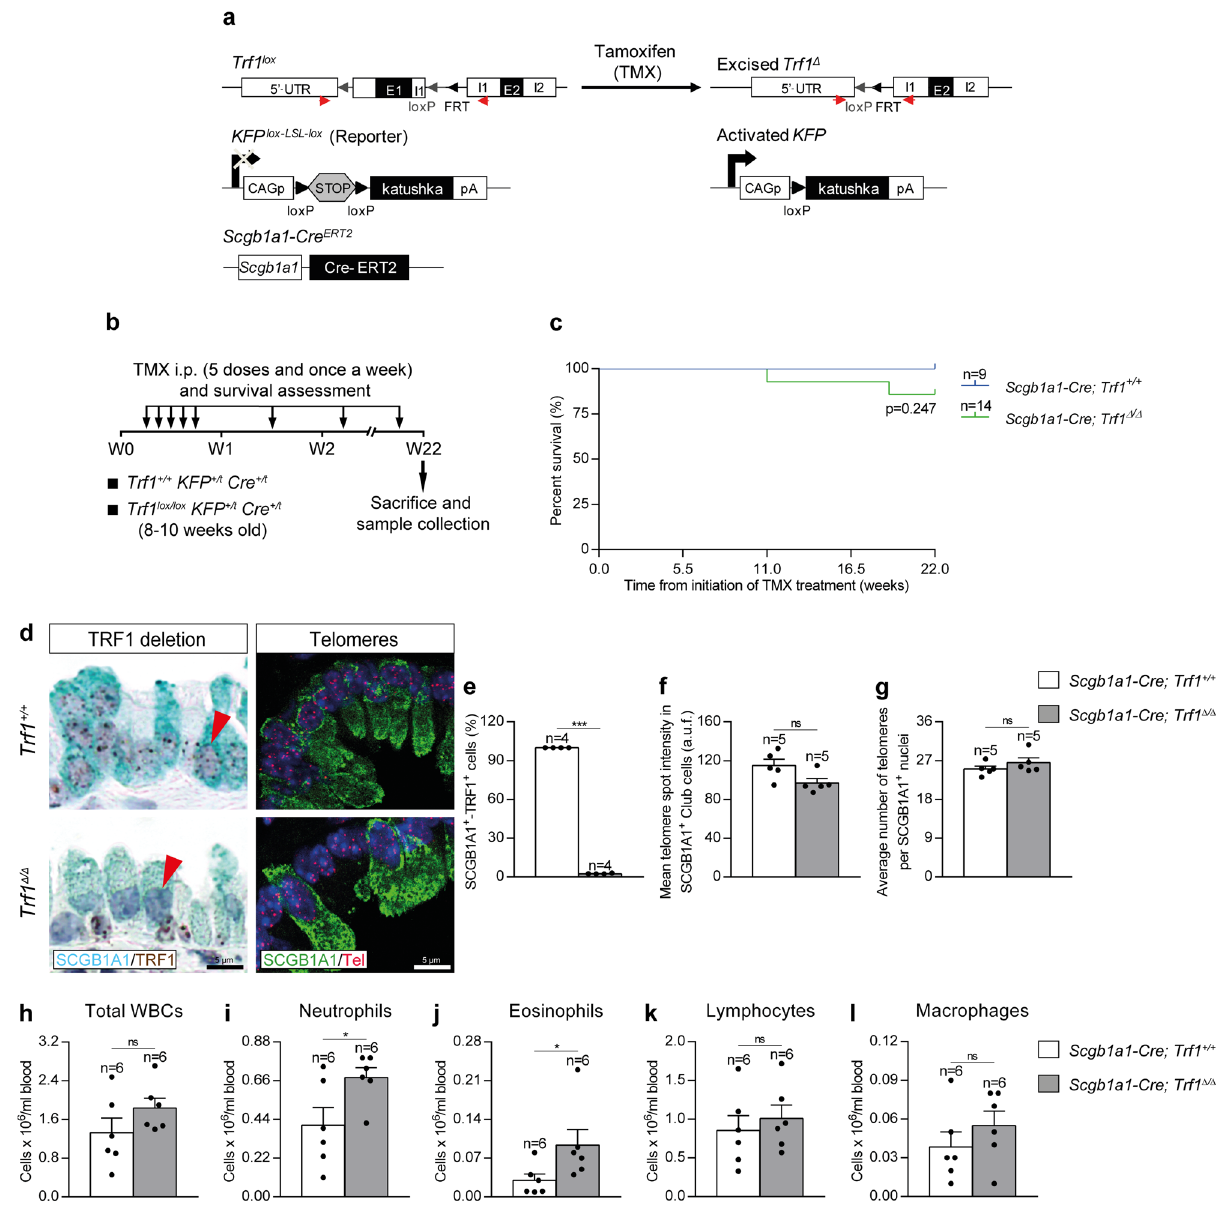
Fig. 5 | Ef fi cient Trf1 deletion in club cells upon tamoxifen administration. a Generationoftheconditionalknockoutmousemodelinwhich Trf1 wasdeletedin club cells using the Cre recombinase driven by the Scgb1a1 promoter. Trf1 lox , KFP Lox-LSL-Lox , and Scgb1a1-Cre ERT2 alleles are depicted before and after Cre-mediated excision. b Tamoxifen (TMX) treatment, survival rate assessment and sample col- lection. Eight-to 10-week-old male Trf1 +/+ KFP +/t Cre +/t ( Scgb1a1-Cre; Trf1 +/+ ) and Trf1 lox/lox KFP +/t Cre +/t ( Scgb1a1-Cre;Trf1 lox/lox )micewerei.p.injectedwithTMXfor fi ve consecutive days during the fi rst week and once a week until the sacri fi ce and sample collection on week (W) 22. c Kaplan – Meier survival curves of Scgb1a1-Cre; Trf1 +/+ ( Trf1 +/+ , controls) and Scgb1a1-Cre;Trf1 Δ / Δ ( Trf1 Δ / Δ ) miceupon TMX treatment. d Representative immunostainings for SCGB1A1 (blue) and TRF1 (brown) (red